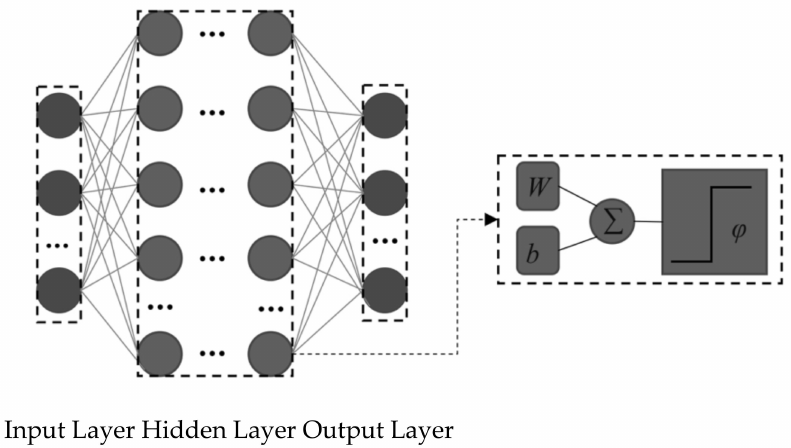
Figure 2. Simplified structure of the multilayer perceptron.